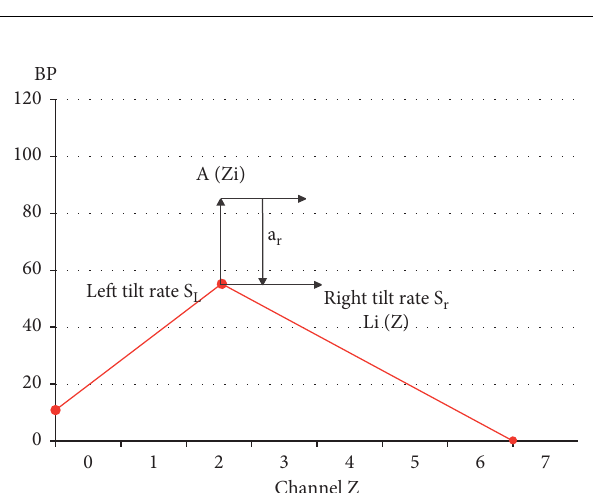
Figure 10: Spread function of frequency band z.